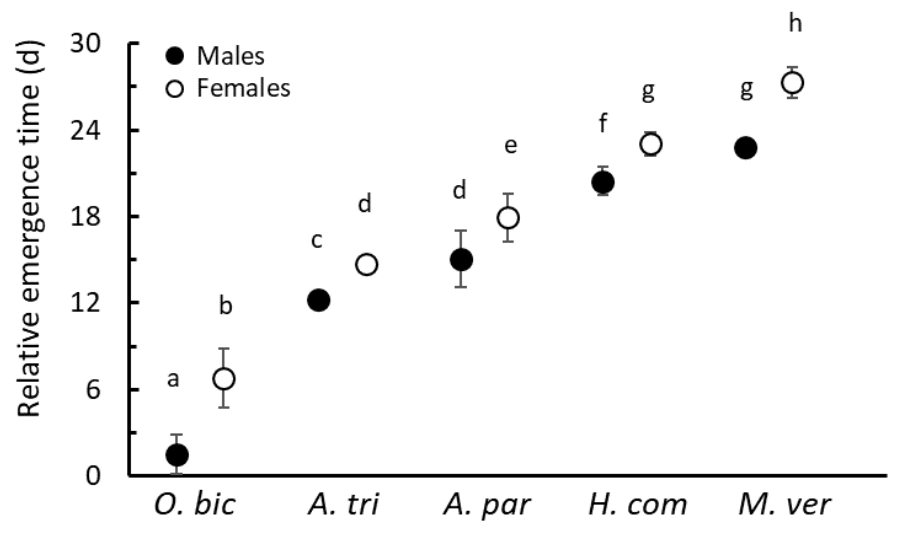
Figure 4. Relative emergence time (d; mean ± 95% CI) of male (closed circles) and females (open circles) of five species of stem- nesting Hymenoptera from cardboard nest tubes. Mean emergence times were calculated for males and females emerging from a single tube, and are relative to 31 st March 2020. Letter codes separate groups based on LSD values from REML analysis at P <